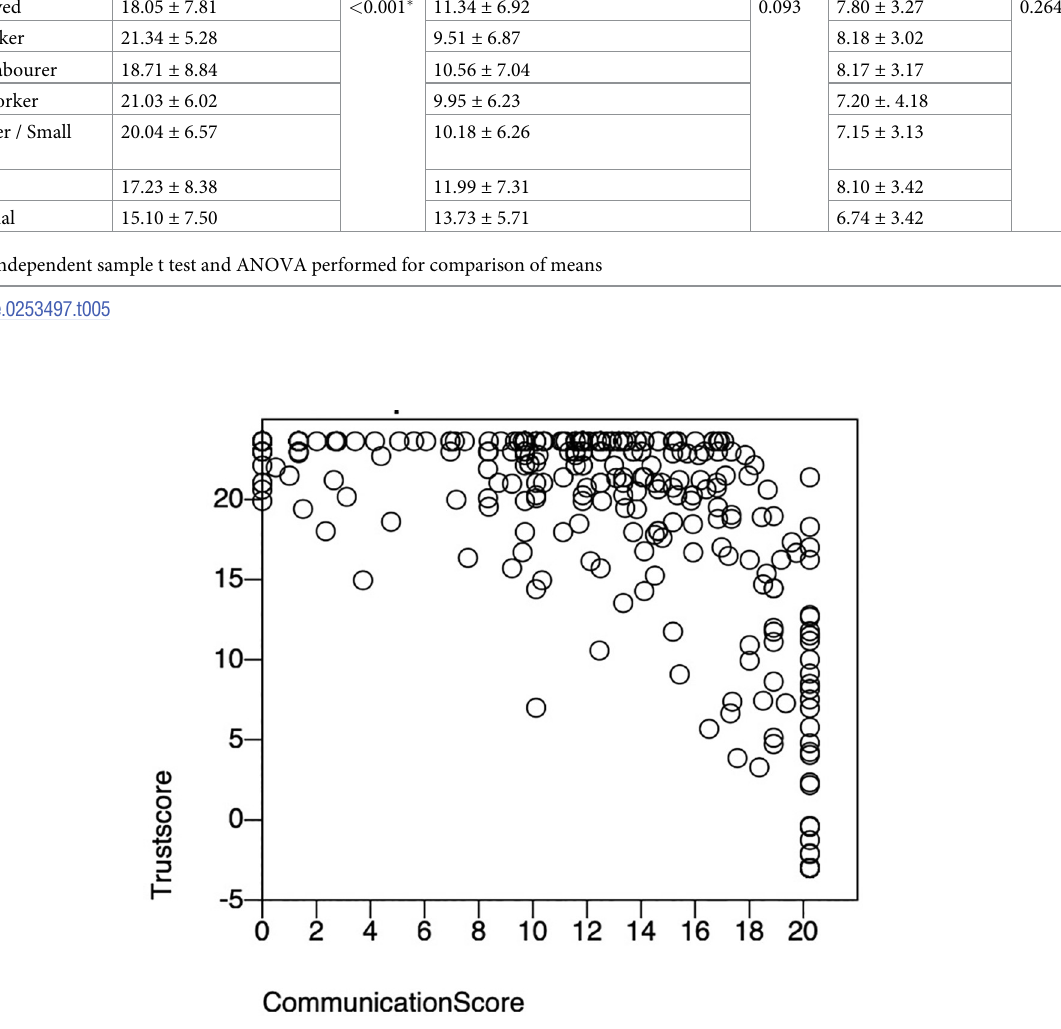
Fig 1. Association between problem with communication and trust in